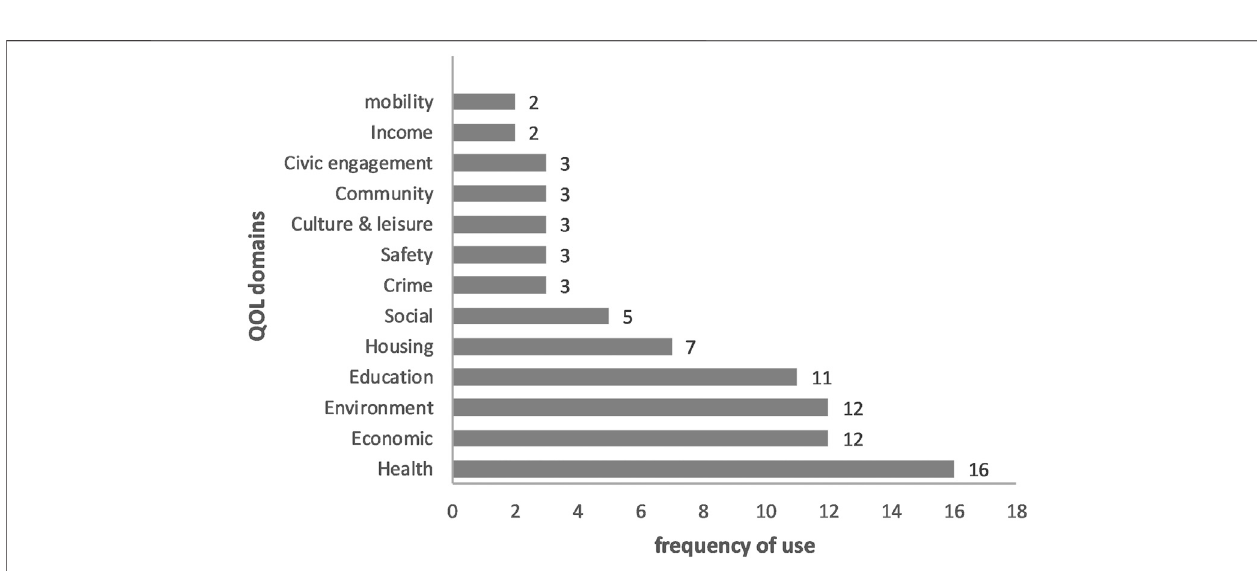
FIGURE 5 | List of most frequently used domains in the examined tools and their usage frequency (i.e., number of tools in which a domain is used).